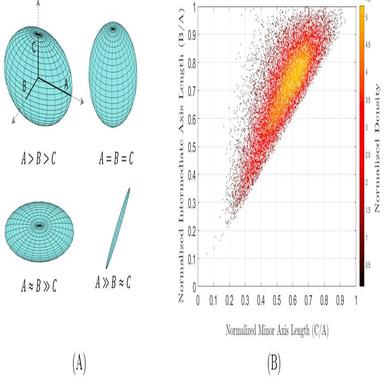
A) Examples of the limiting cases for AD85 pore shapes that can be presented using general ellipsoids. B) Intermediate axis length plotted against minor axis length. Both lengths are normalized by the major axis. Color bar shows normalized density. (For interpretation of the references to color in this figure legend, the reader is referred to the Web version of this article.)